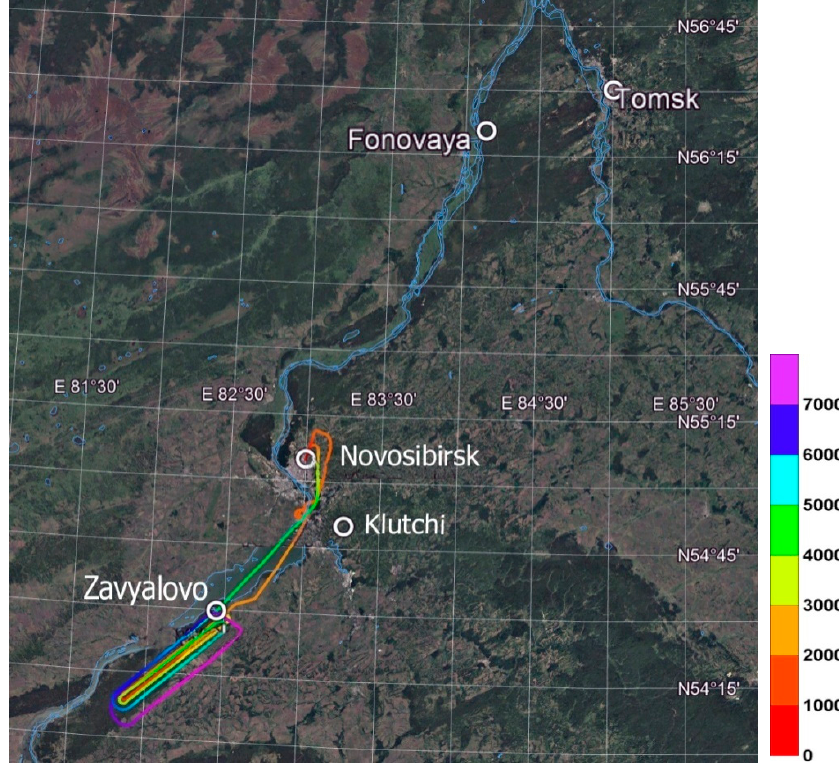
Figure 1. Geographic positions of the measurement sites and flight paths of the aircraft laboratory (color lines). Google Earth (Image Landsat/Copernicus).